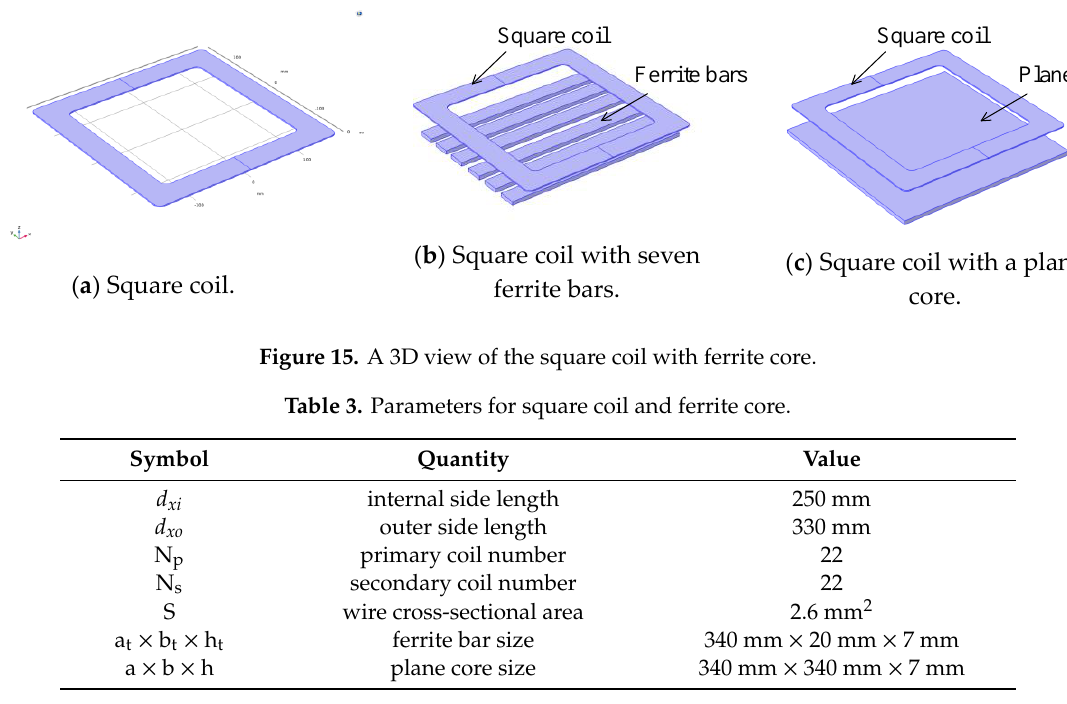
Figure 15. A 3D view of the square coil with ferrite core .